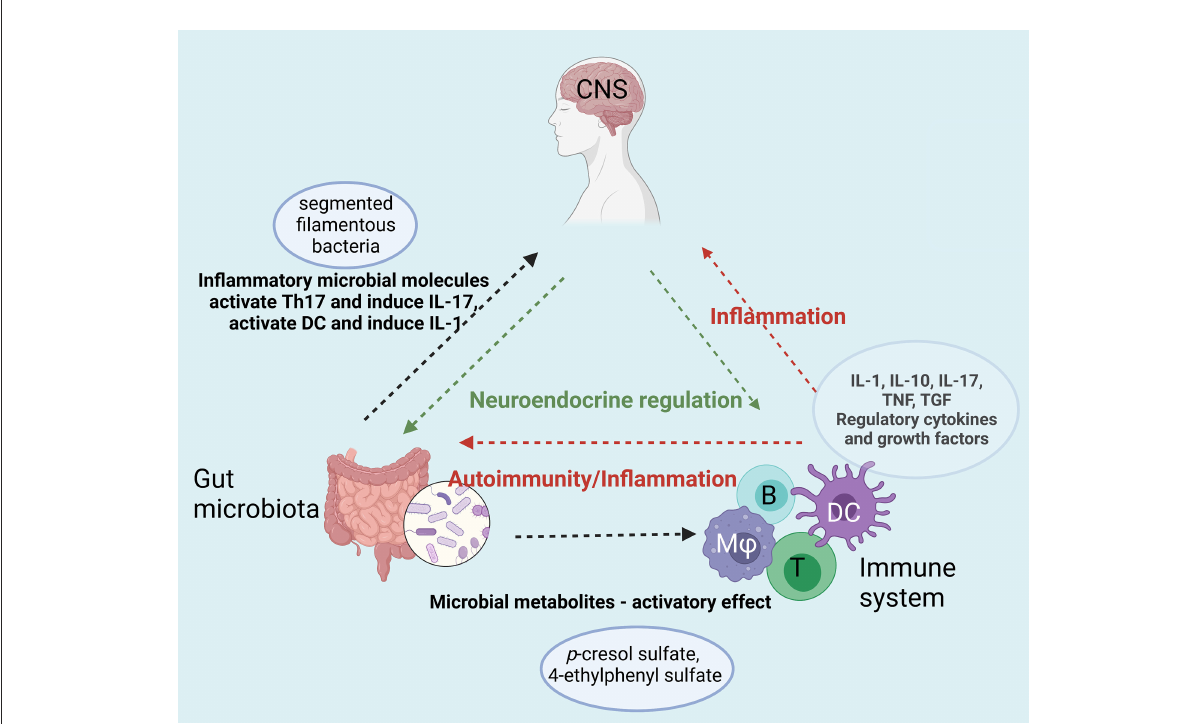
FIGURE3 Immune-Gut-Brain network that converge toward sustaining neuroinflammation in ASD. Gut microbiota enhances the inflammatory status by specific microbial metabolites (e.g., p-cresol sulfate, 4-ethyphenyl sulfate) that activate both innate (dendritic cells, macrophages) and adaptive immune cells (T and B lymphocytes). The enhanced pro-inflammatory cytokine secretion and the auto-antibodies generated upon this hyperactivation act on both digestive system and on the central nervous system sustaining the neuroinflammation. Moreover, gut